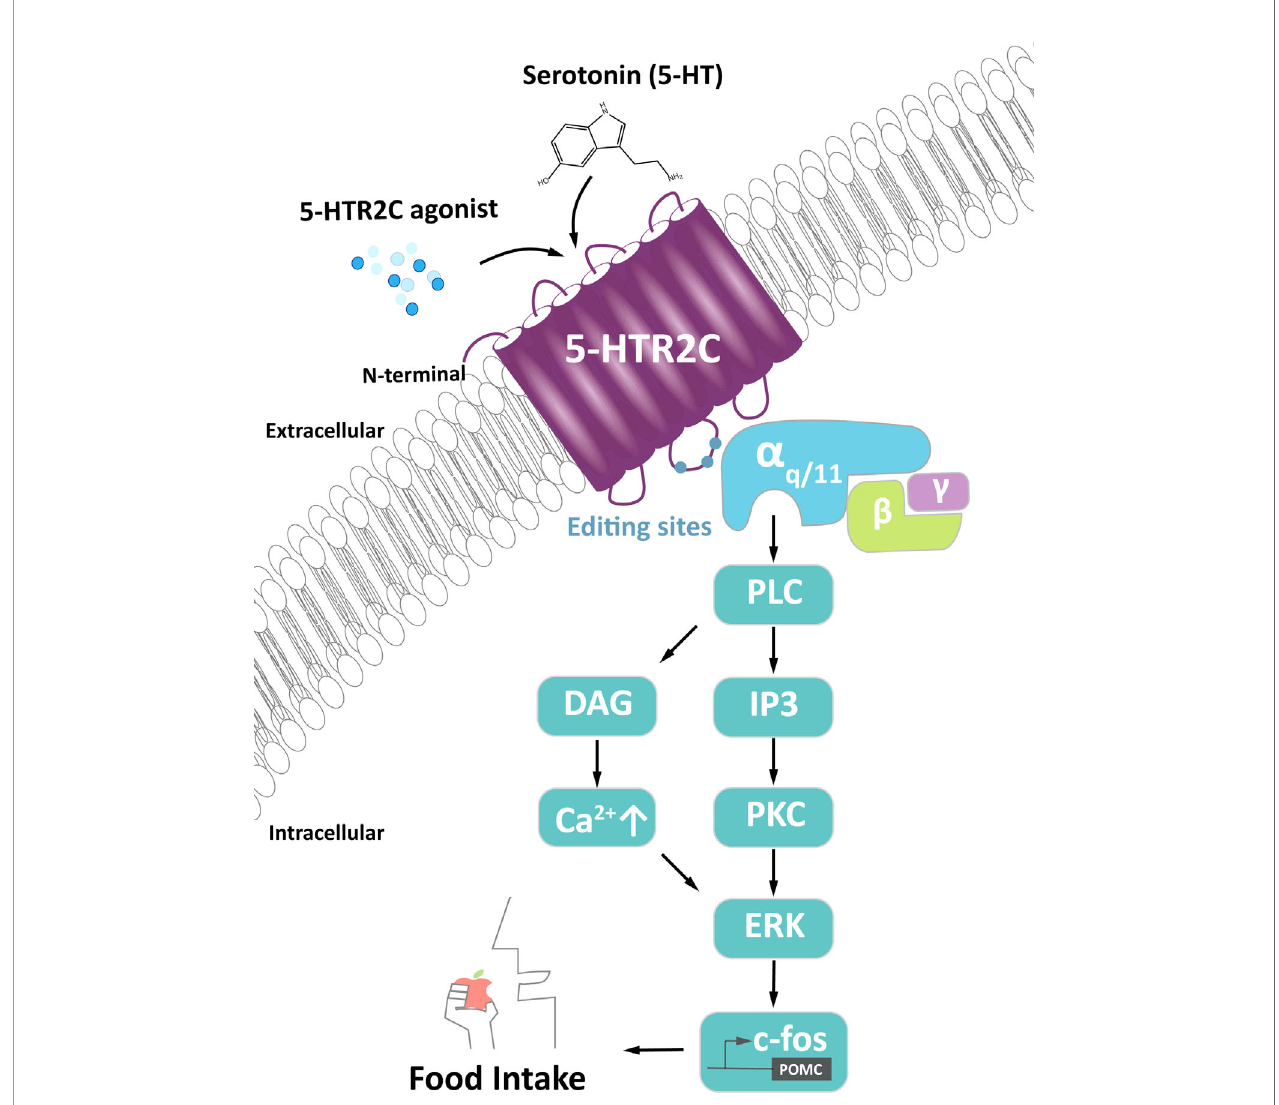
FIGURE 1 | Signaling of 5-HTR2C in POMC neurons generating food intake. Activation of a q/11 promotes phospholipase C (PLC) to produce diacylglycerol (DAG) and inositol-1,4,5-triphosphate (IP3). IP3 promotes release of intracellular calcium (Ca 2+ ) while DAG binds to downstream effector protein kinase C (PKC), both of which activates c -Fos via the extracellular regulated kinase pathway (ERK). C- Fos turns on the pro-opiomelanocortin (POMC) promoter, which signals to neurons regulating the food intake signal. This signal is also regulated by 5-HTR2C agonist and